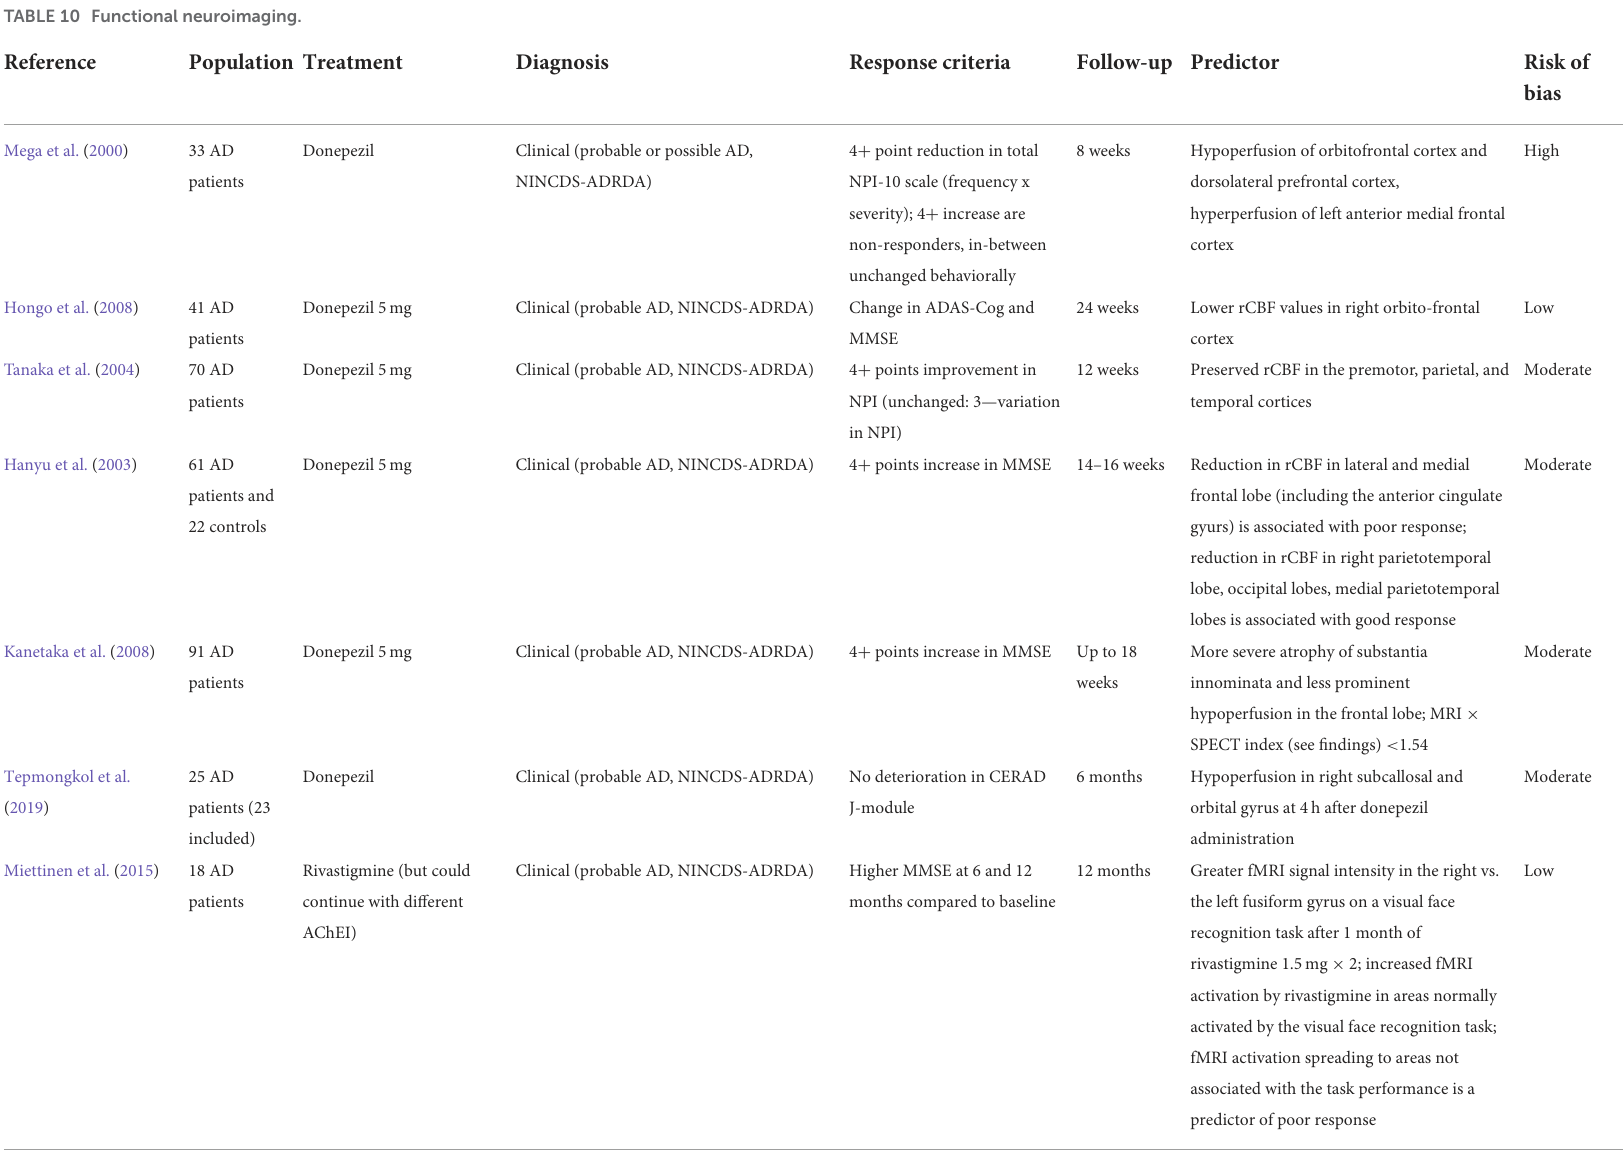
TABLE 10 Functional